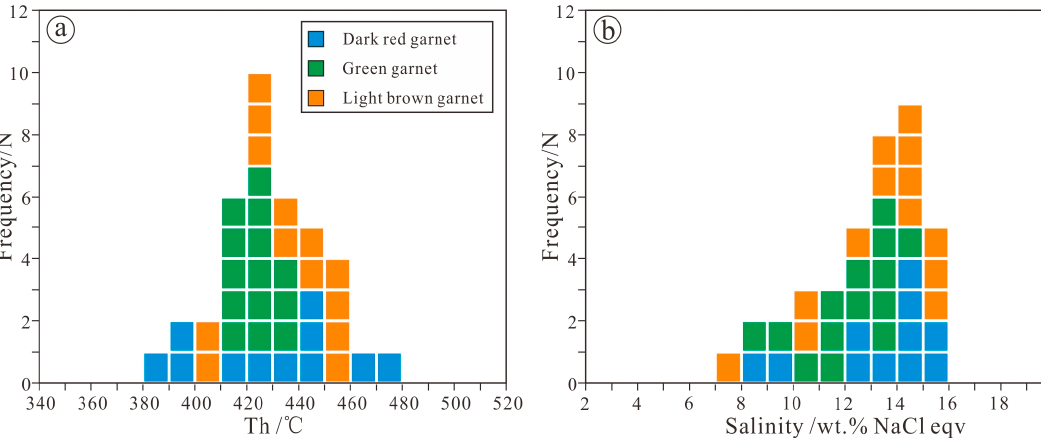
Figure 12. Histograms of the ( a ) homogenization temperatures and ( b ) salinities of the fluid inclusions in the Yongping garnets.